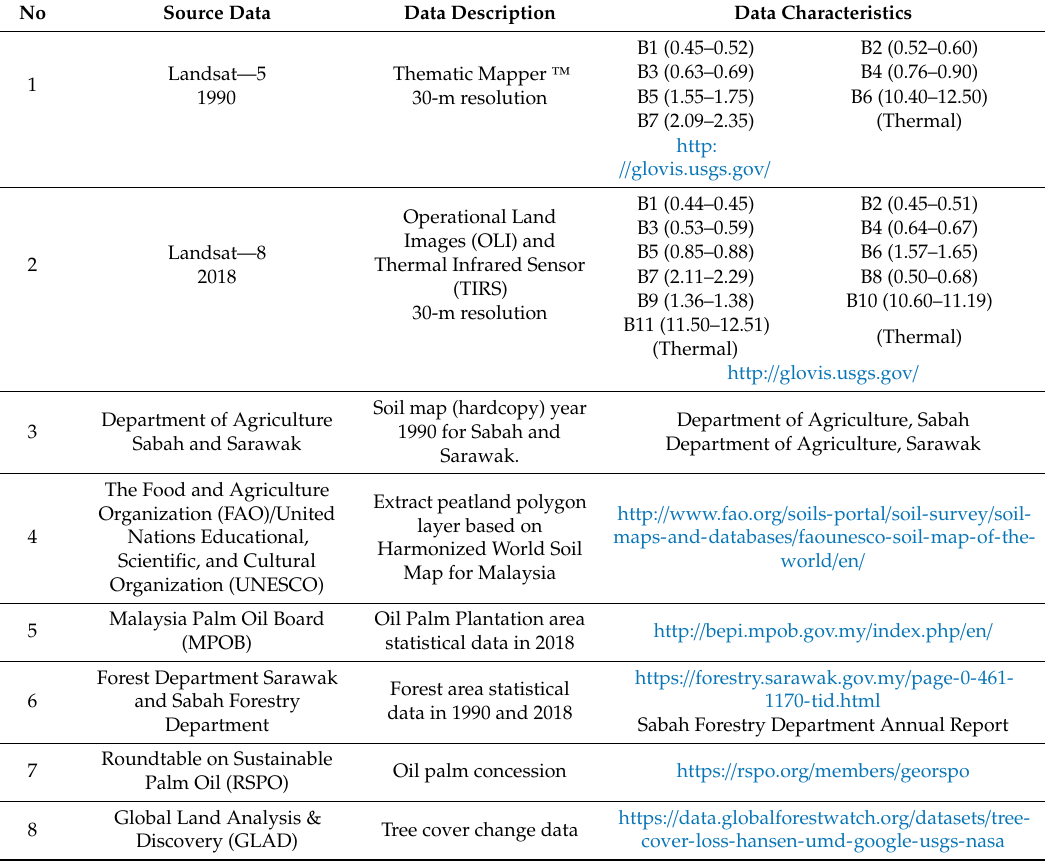
Table 1. Datasets specification used in the